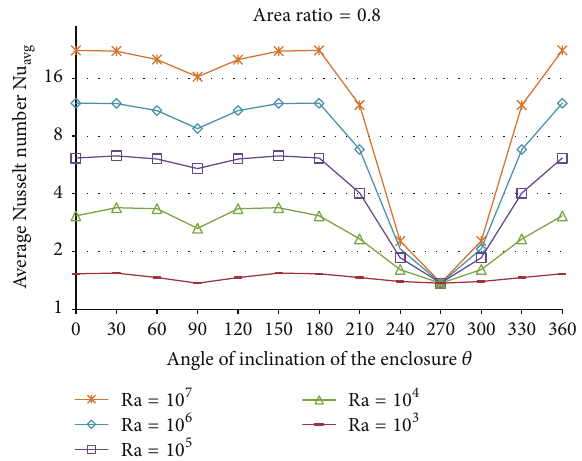
with 𝜃 at different Rayleigh numbers avg